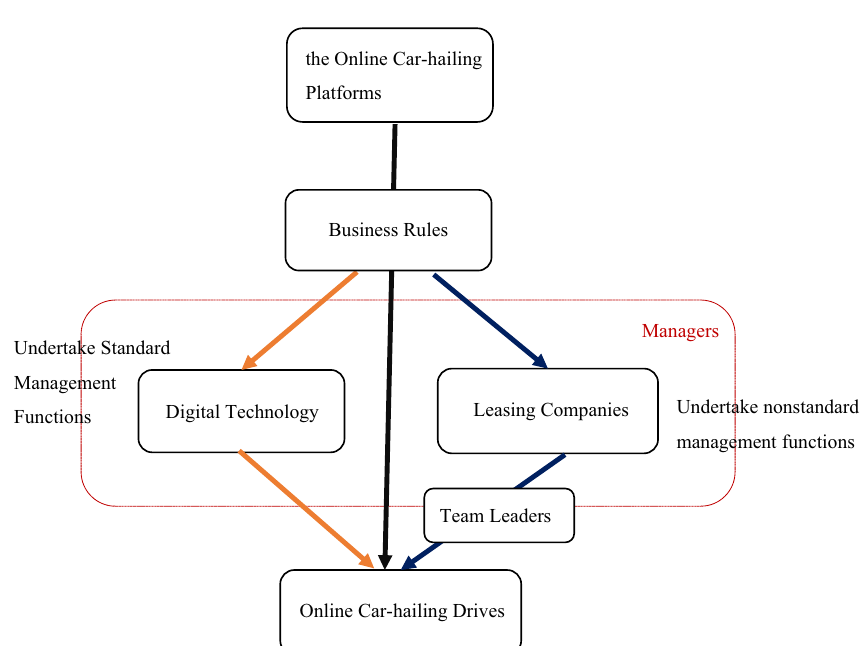
Fig. 1 The relationship among the platforms, business rules, digital technology, leasing companies and